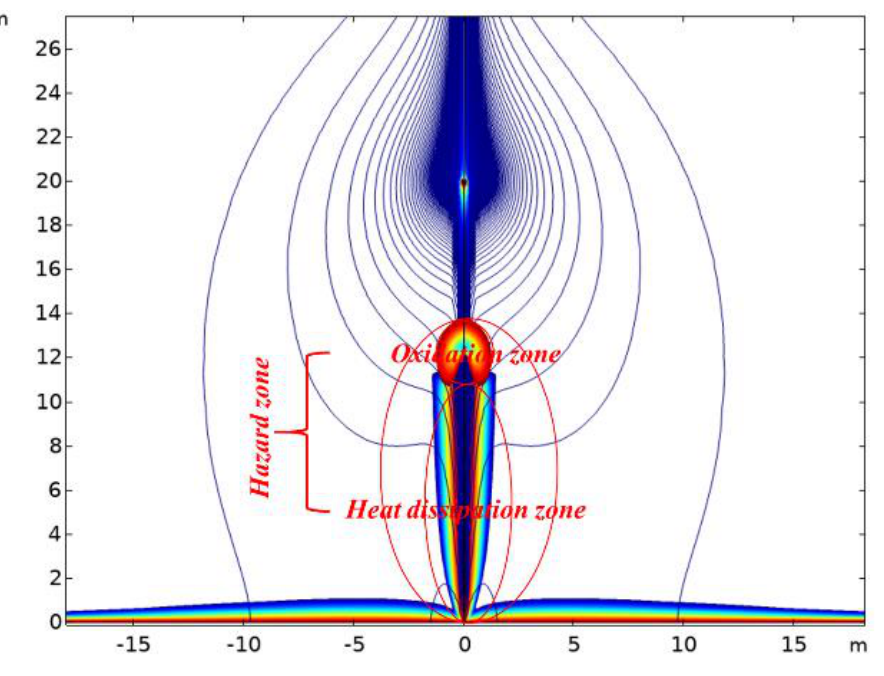
Figure 2. Diagram of the dangerous area around borehole.